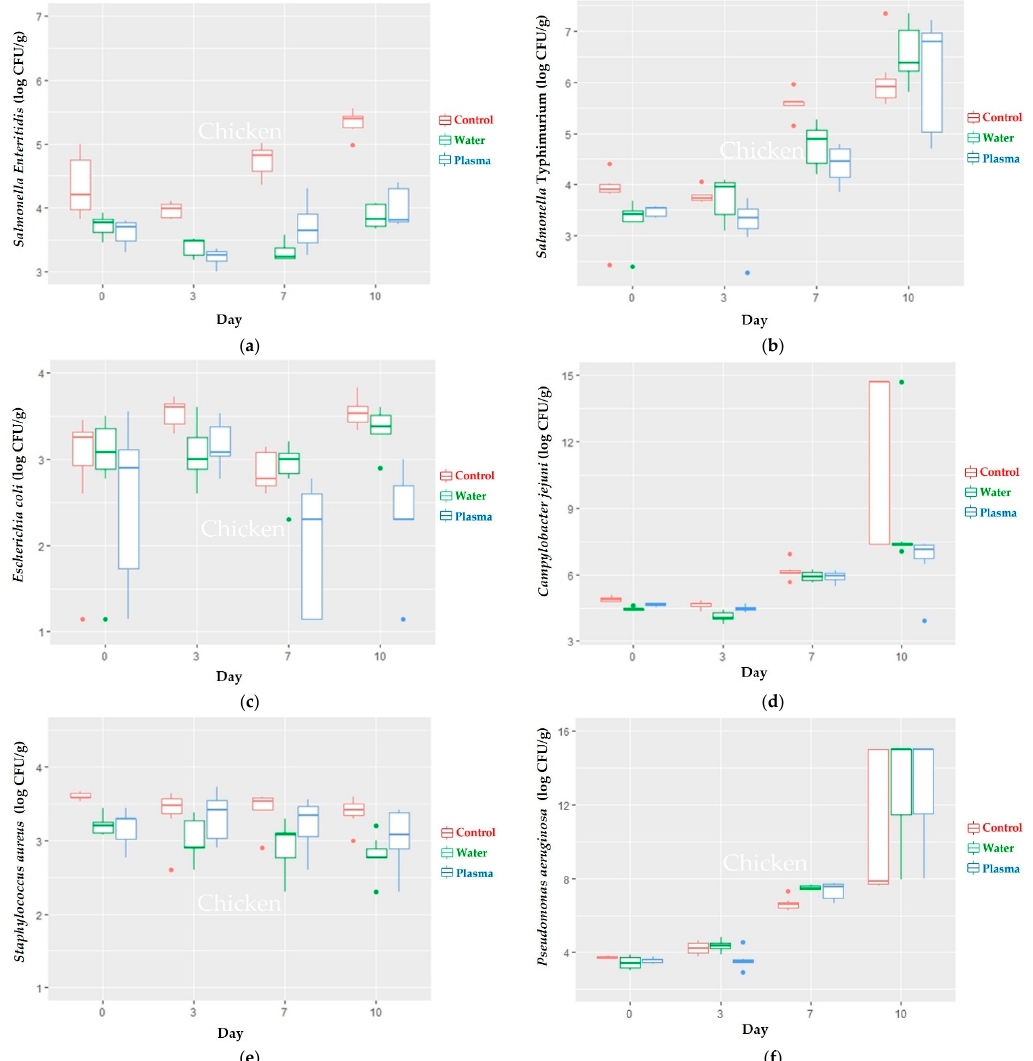
Figure 3. Microbial loads of ( a ) S . Enteritidis, ( b ) S . Typhimurium, ( c ) E. coli , ( d ) C. jejuni , ( e ) S. aureus , and ( f ) P. aeruginosa of chicken samples at day 0 of the experiment and after being stored at 4–6 °C for 10 days ( p ≤ 0.05).